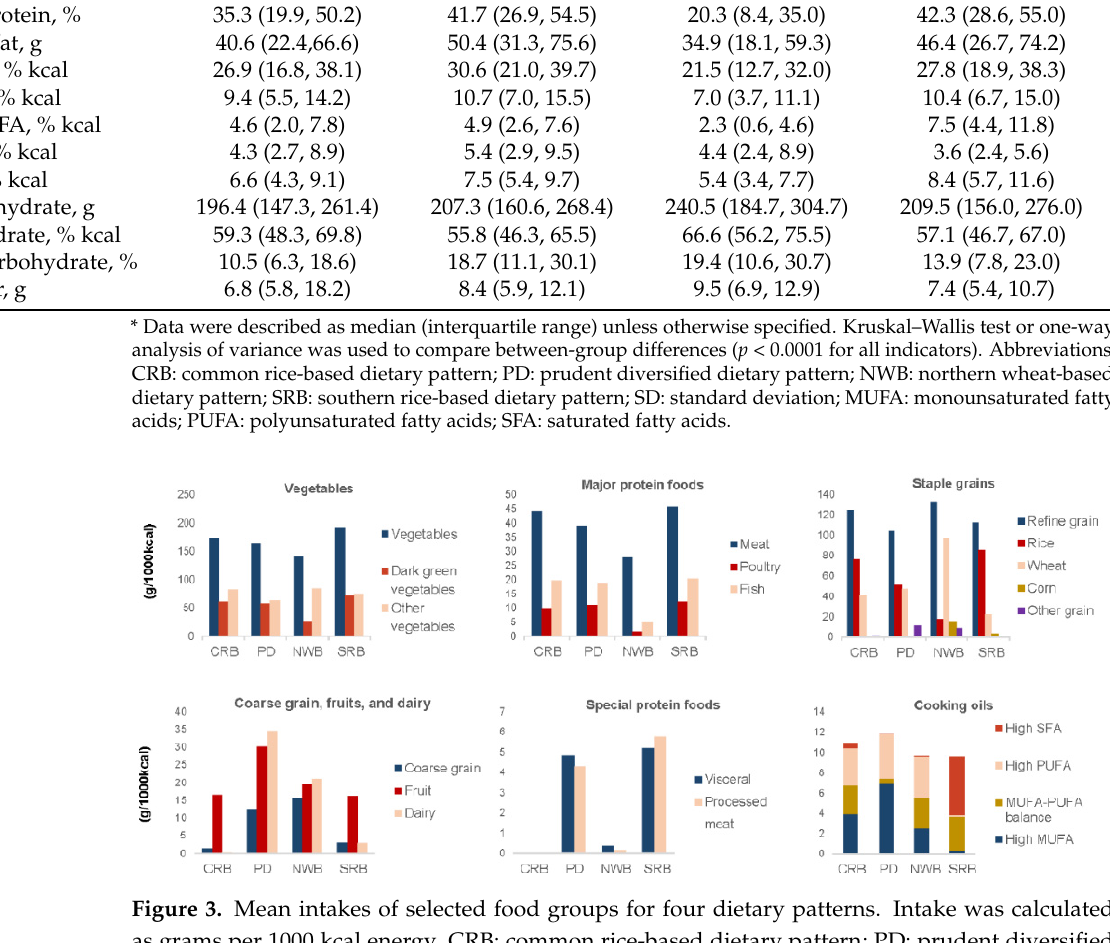
Supplementary Materials Table S7 in File S9), the PD and the NWB both had higher odds with higher education level and urban residence, but the PD had higher odds with higher household income while the NWB lower (Supplementary Materials File S10). The SRB also had lower odds with higher education levels. Moreover, people with SRB had higher physical activity while NWB was lower. All p values for the above comparisons were sig ‐ nificant. 3.4. Association of Dietary Patterns with Overweight/Obesity and Hypertension Figure 5 displays the estimated overall and subgroup associations between dietary patterns and overweight/obesity and hypertension, with CRB as the reference group.